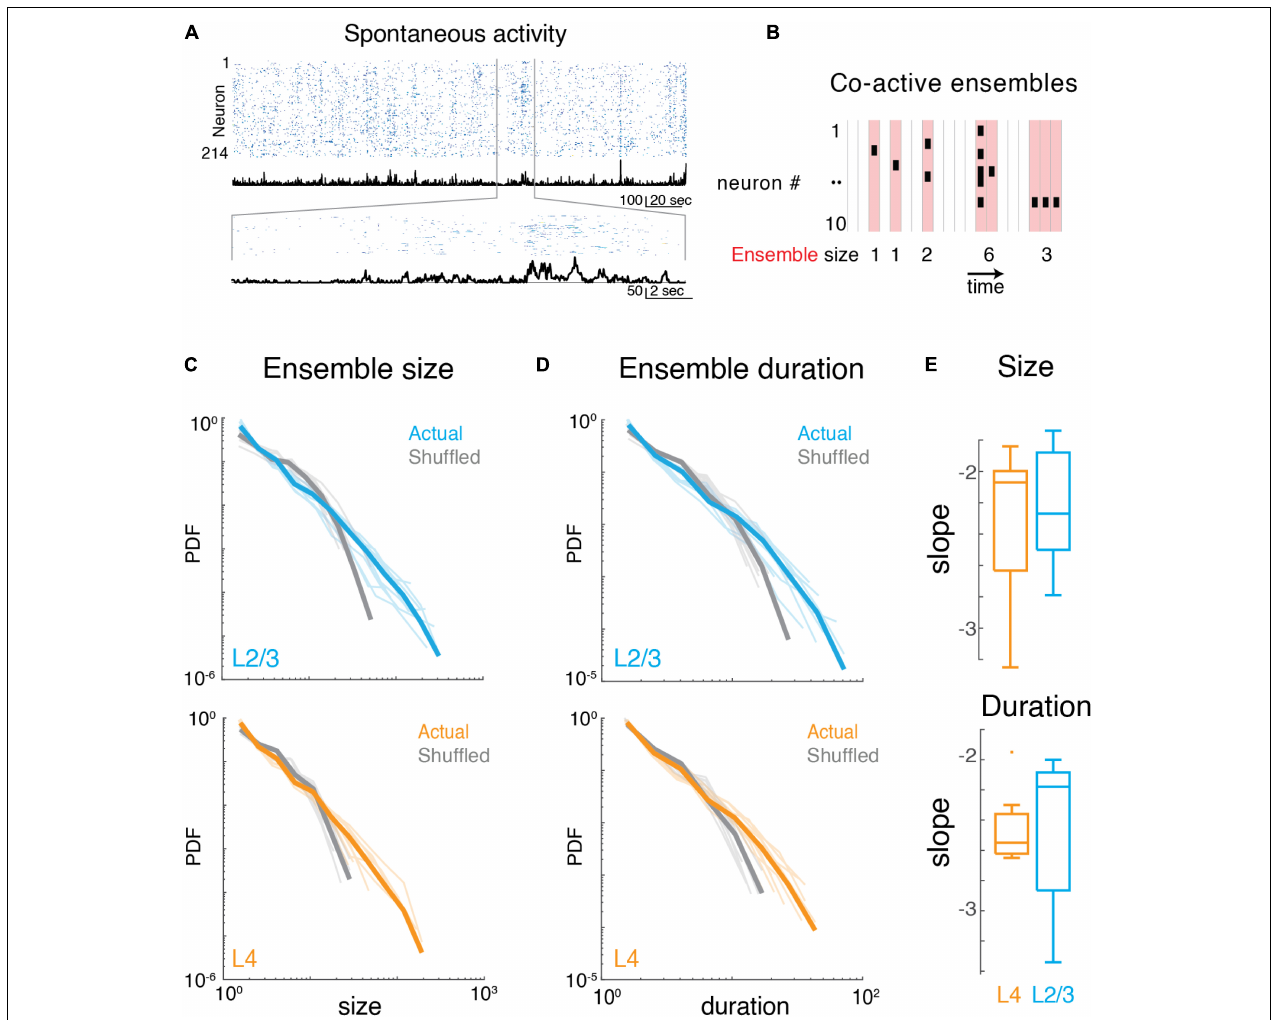
FIGURE 3 | Imaging neuronal ensemble activity in awake mouse A1. (A) Top: Binarized raster plot of ongoing activity recorded from L2/3 pyramidal neurons with corresponding population activities (black). Middle: Expanded view of raster plot revealing variable ongoing activity with population activities. (B) Schematic depicting definition of activity ensembles from a neuronal activity raster. Activity from successive time bins/frames in which at least one neuron is firing (black rectangles) is concatenated into an activity ensemble (shading; five ensembles shown). Ensembles are separated by at least 1 frame with no activity. Vertical gray lines indicate boundaries of frame acquisition ( (cid:49) t, 33 ms). Ensemble sizes defined as the number of spikes in each ensemble are indicated below. (C) Probability density distributions of ensemble sizes from individual experiments in L4 and in L2/3. Gray lines indicate distributions from shuffled data. (D) Probability distributions of activity ensemble duration of ongoing activity from all experiments in L2/3 and in L4. Gray lines indicate distributions from shuffled data. Faded lines indicate individual experiments. (E) Boxplots showing slopes of probability distributions in ensemble size ( top ) and ensemble duration ( bottom ) for each individual experiment in L4 (orange) and L2/3 (blue), Size: α L2 / 3 : –2.23 ± 0.39, α L4 : –2.33 ± 0.52, Duration: α L2 / 3 : –2.47 ± 0.49, α L4 : –2.46 ± 0.26, mean ± SD p > 0.65, unpaired two-sample t